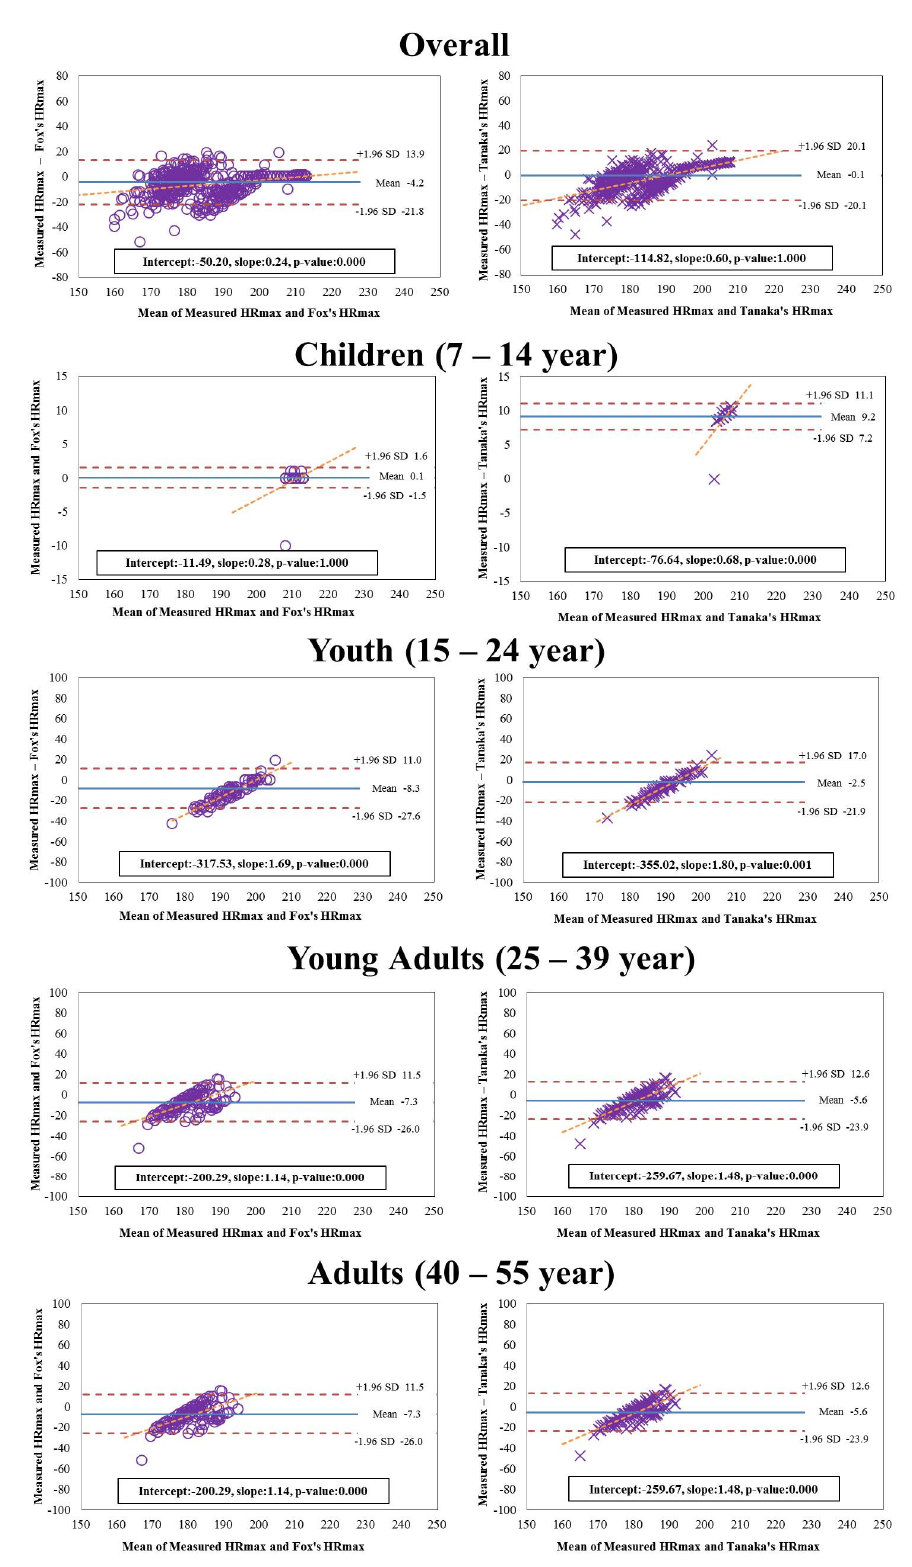
Figure 1. Bland–Altman plots for maximal heart rate estimated by Fox (cid:48) s equation and Tanaka (cid:48) s equation based on direct measured maximal heart